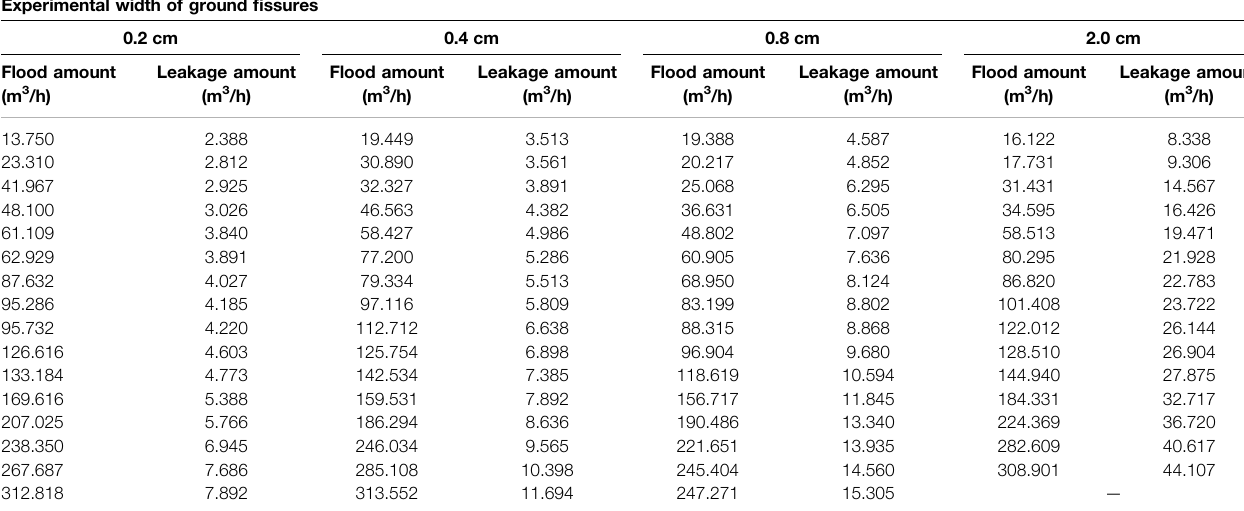
TABLE 3 | Experimental gully leakage under different fl ood volumes and seam widths. Experimental width of ground fi ssures